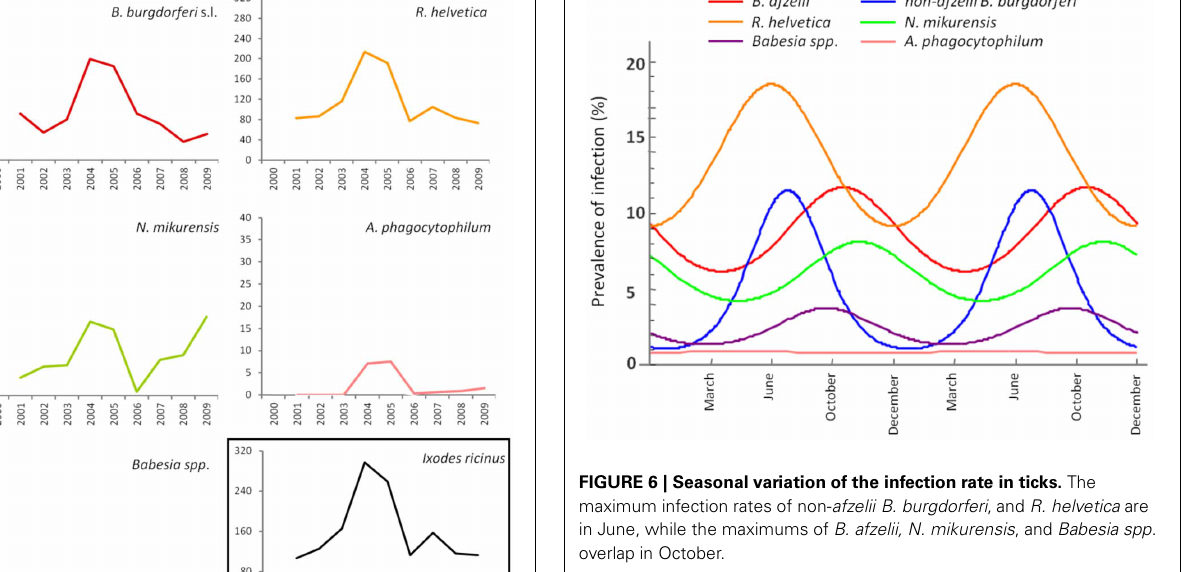
prevalences for B. burgdorferi, A. phagocytophilum , and R.